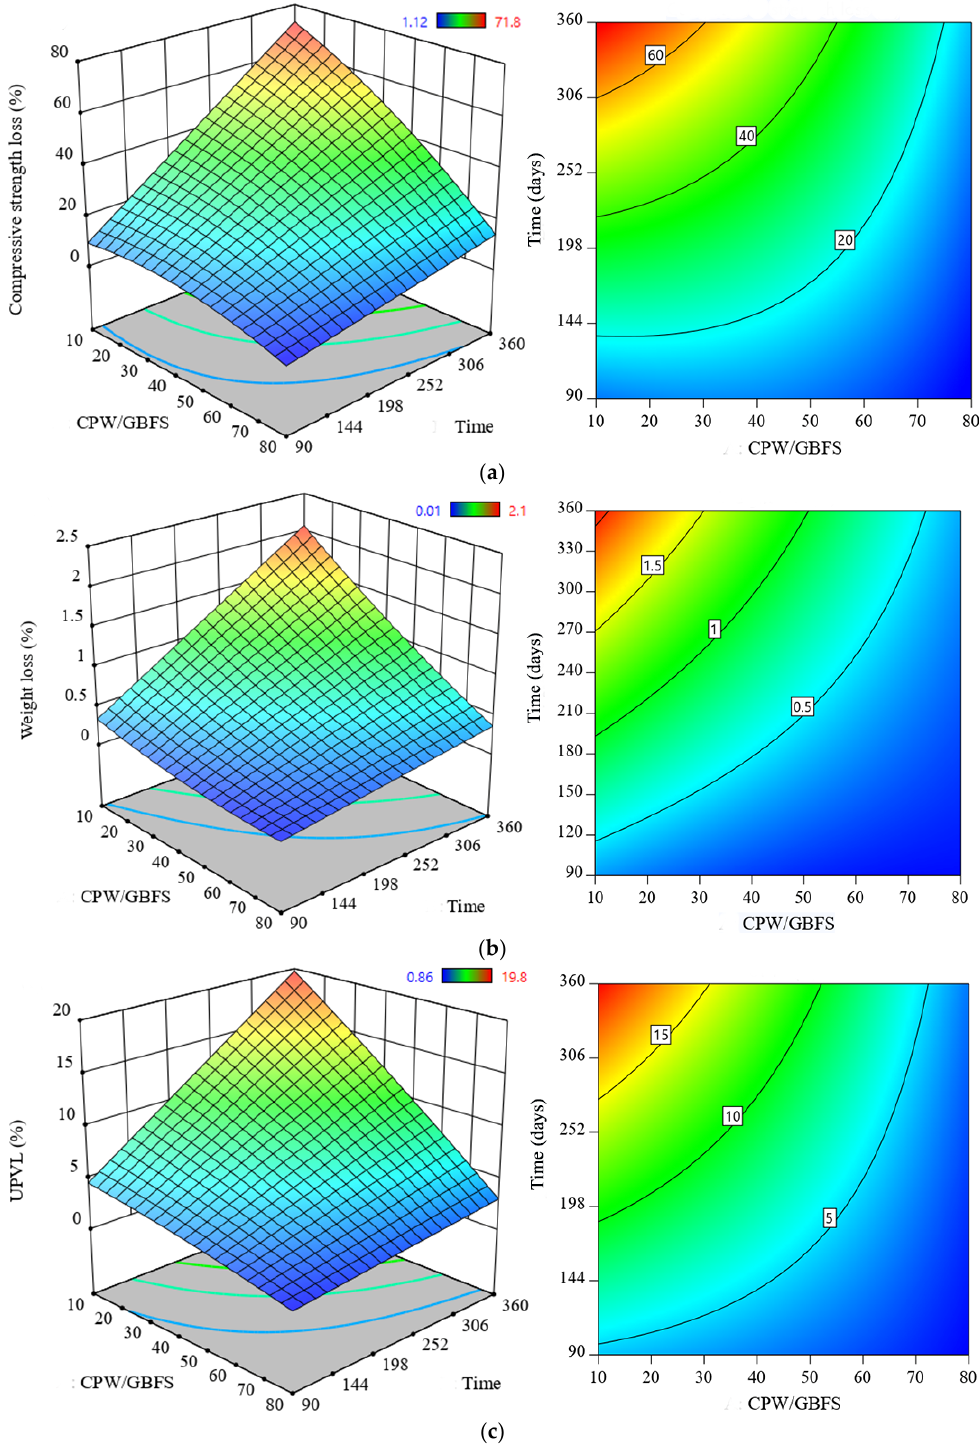
Figure 8. Durability of SCAAC exposed to acid: ( a ) strength loss, ( b ) weight loss, and ( c ) UPVL.